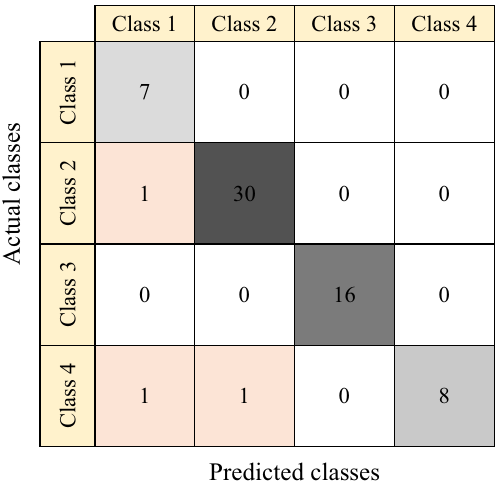
Fig. 13 Accuracy of the algorithms with different percentages of training data